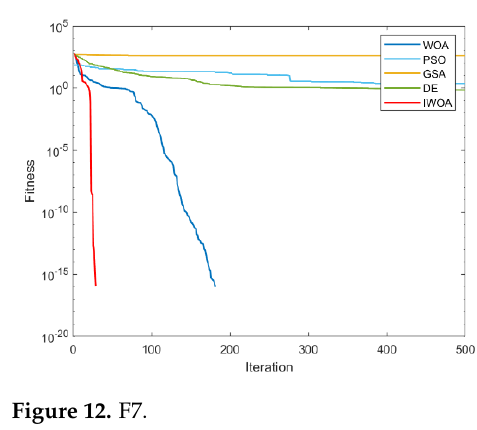
Figure 11. F6. Figure 11. F6.